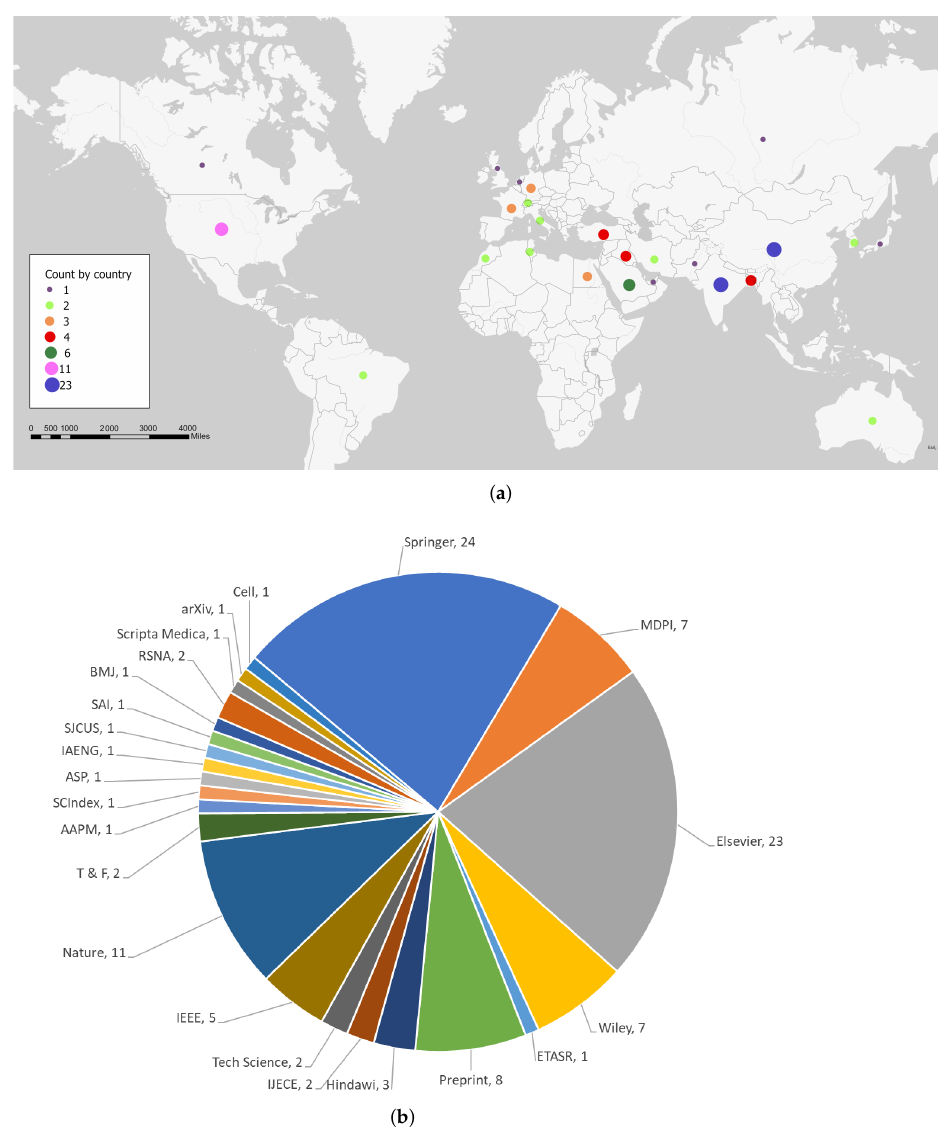
Figure 1. Research presented in this paper summarized based on ( a ) country and ( b )